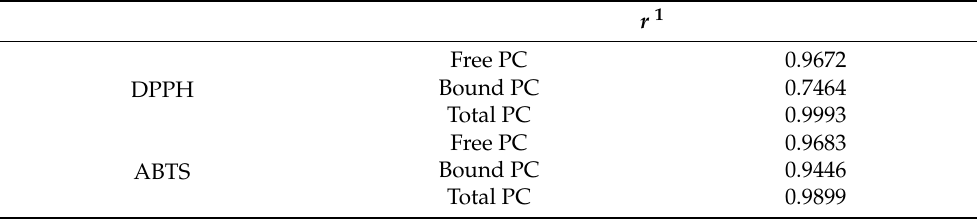
Table 4. Correlation coefficients between scavenging activities and free, bound and total phenolic compound (TPC)